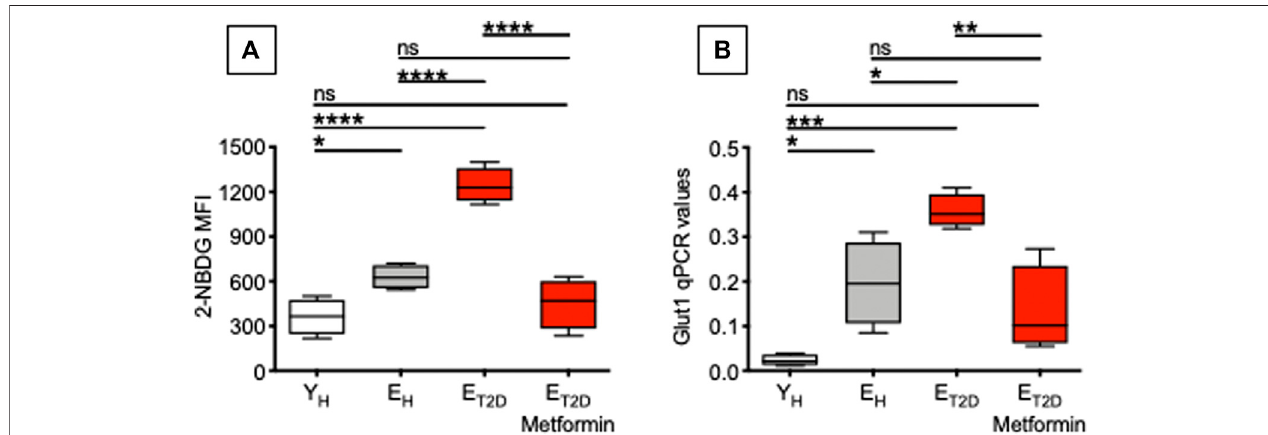
FIGURE4| Metformindecreasesglucoseuptakeinexvivo-isolatedBcellsfromE T2DM patients.Glucoseuptakewasmeasuredby fl owcytometryandtheglucose fl uorescent analog 2-NBDG. (A) MFI (mean fl uorescence intensity) of 2-NBDG staining in B cells from the 4 groups of individuals. (B) qPCR values of Glut1 mRNA expression,relativetoGAPDH,calculatedas2 − Δ Cts inthesameBcellsin (A) .Meancomparisonsbetweengroupswereperformedbyone-wayANOVA. * p < 0.05, ** p